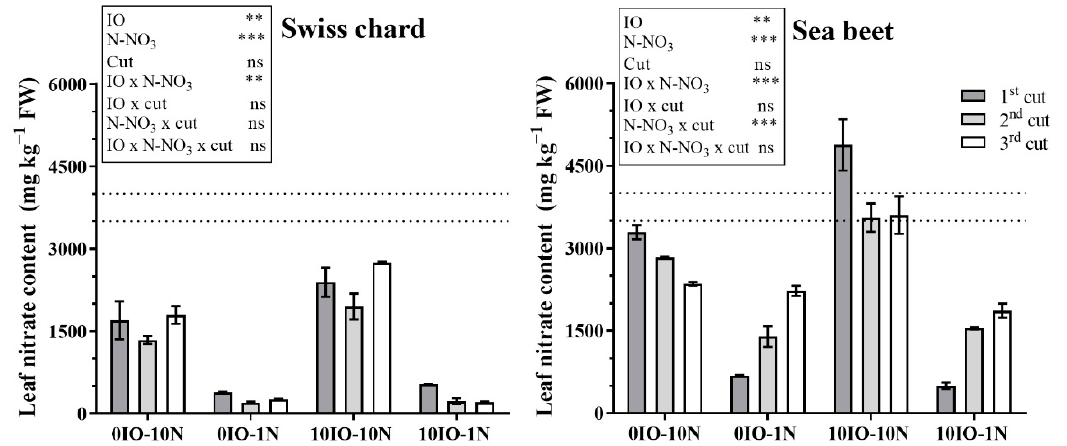
Figure 2. Leaf nitrate content of Swiss chard (left) and sea beet (right) grown hydroponically under greenhouse with different concentrations of the sea salt Instant Ocean (IO; 0 and 10 g L − 1 ) and nitrogen (1 and 10 N-NO 3 mM) in the nutrient solution (see Table 2 for abbreviations). Plants were harvested trice during the experiment. Dotted lines indicate the maximum levels of nitrates set by the Commission Regulation EU no. 1258/2011 for lettuce grown under greenhouse in spring–summer season and for spinach (4000 and 3500 mg kg − 1 FW, respectively). The mean values ( n = 3) are reported with standard error. The results of ANOVA are reported inside the graph. Significance level: *** p ≤ 0.001; ** p ≤ 0.01; ns = not significant. Table 5. Leaf production (fresh weight, FW), dry weight/fresh weight ratio (DW/FW), leaf area and succulence of Swiss chard plants grown hydroponically with different concentrations of the sea salt Instant Ocean (IO; 0 and 10 g L − 1 ) and nitrogen (1 and 10 N-NO 3 mM) in the nutrient solution. The leaves were harvested trice during the experiment (see Table 1 for more detailed information on the experiment).